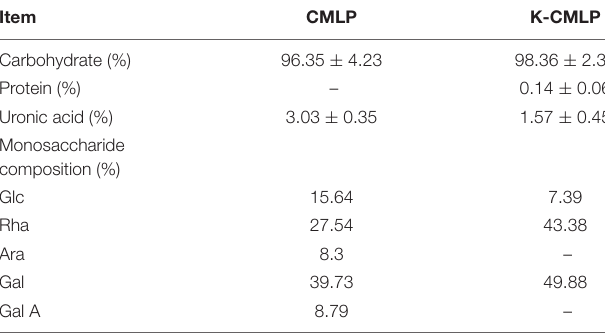
Frontiers in Nutrition |